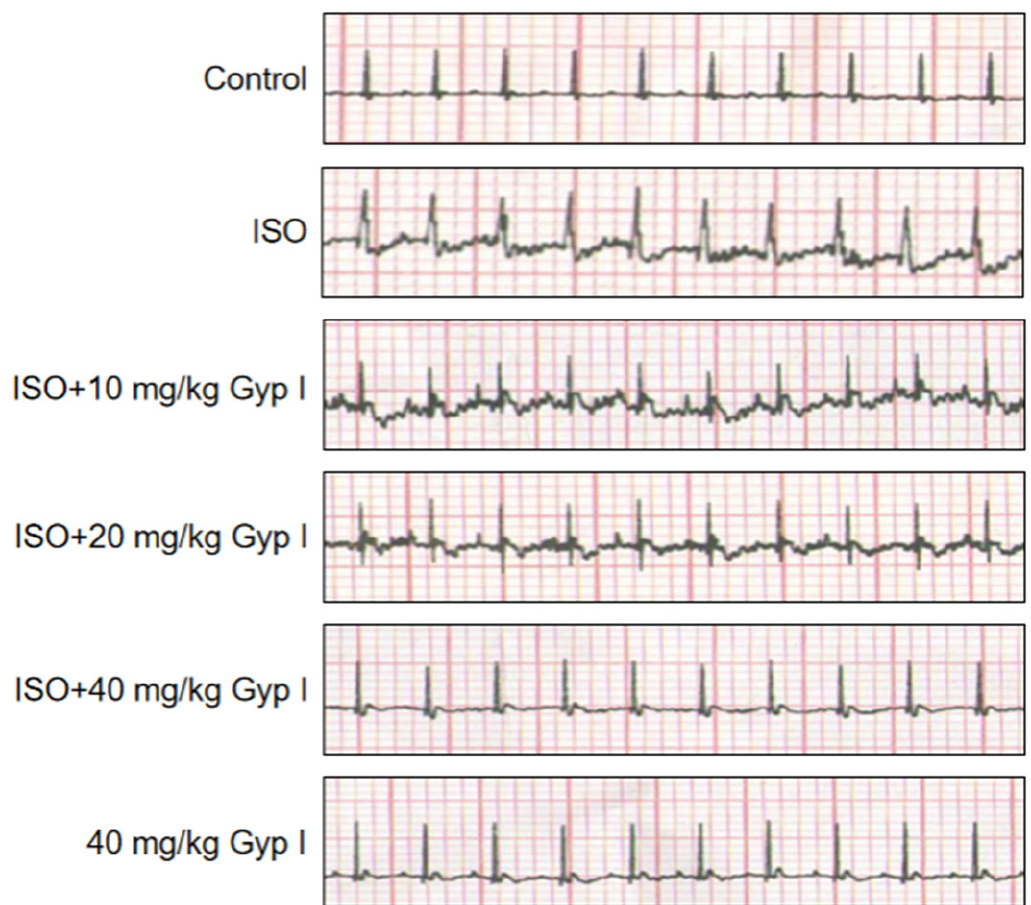
Figure 6. Representative images of ECG analysis of various treatment group mice.